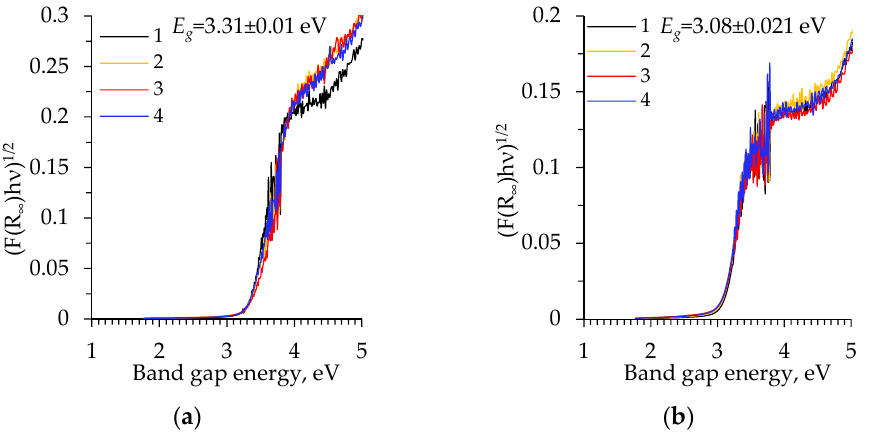
Figure 11. Tauc plot of the aged TiO 2 aerogels: ( a ) without calcination; ( b ) after calcination. 1–2 curves correspond to the precursor TIP and 3–4—to TBOT: 1, 3—without solvent exchange; 2, 4—nH-exchanged.